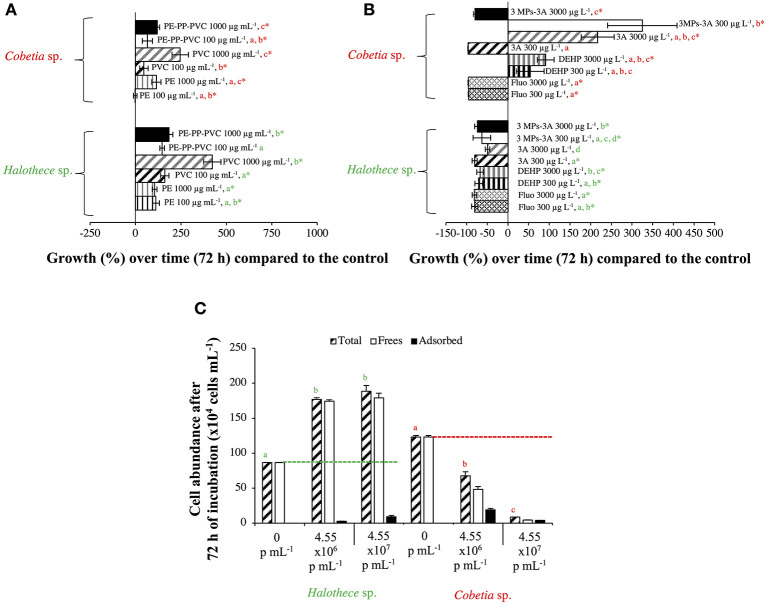
Growth responses of diazotrophs subject to high concentrations (the “worst-case” scenario) of MPs and additives after 72 h, compared with the control value. (A) Effect of MPs (PE, PP, and/or PVC, 100/1,000 μg mL−1). The effect of PP alone with non-significant results is not included in the graph. (B) Effect of organic additives (fluoranthene, HBCD, and/or DEHP, 300/3,000 μg L−1). The effect of HBCD alone with non-significant results is not included in the graph. (C) Effect of PS beads. Total, free and adsorbed bacteria (to the beads) are differentiated. Values are the mean, and the error bar is the standard error between the replicates (n = 3). Letters indicate pairwise analysis among the variables (i.e., concentration) inside each strain (see the different colors), and asterisks (*) indicate pairwise significant differences between variables and the control (p < 0.05), using a post-hoc test (Wilcoxon) after Kruskal-Wallis over the whole dataset.